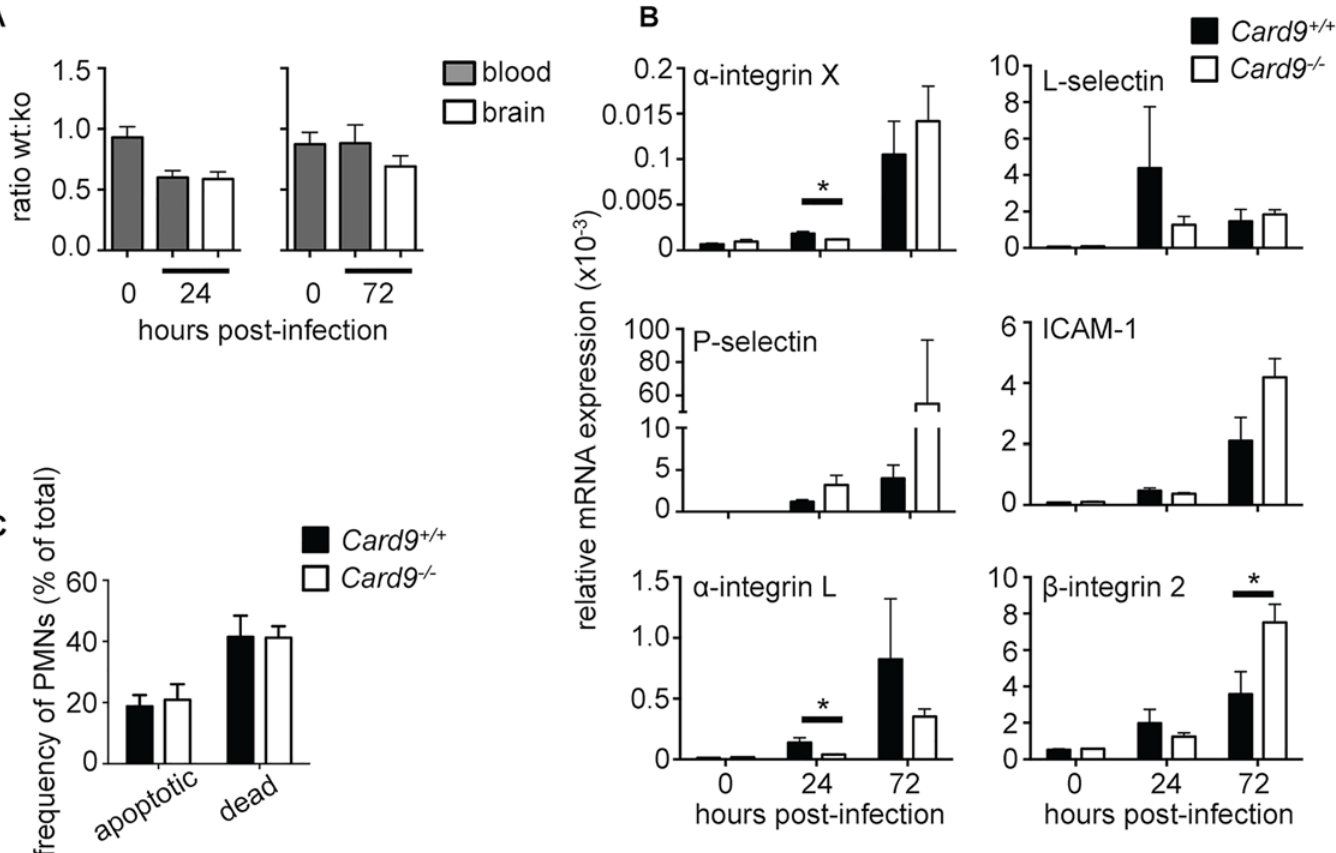
Fig 7. CARD9 deficiency does not affect cell-intrinsic neutrophil chemotaxis, survival or expression of adhesion molecules. (A ) The ratio of CD45.1 + WT neutrophils to CD45.2 + Card9 -/- neutrophils in mixed bone marrow chimeras was determined by FACS in the blood prior to infection and in the blood and brain at 24 (left panel) and 72 hours (right panel) post-infection (n = 7 – 8 per time point). ( B ) Expression of various adhesion molecules in whole brain homogenates of uninfected and infected WT (filled bars, n = 6) and Card9 -/- (empty bars, n = 6) mice, as determined by qRT-PCR. Gene expression was calculated relative to Gapdh. Mice analyzed at 24 hours were infected with 1.3x10 5 CFU SC5314, and mice analyzed at 72 hours infected with 7x10 4 CFU. ( C ) Neutrophil survival in the brain of 24-hour infected (dose: 1.3x10 5 CFU) WT (filled bars, n = 6) and Card9 -/- (empty bars, n = 6) mice was determined by Annexin-V and 7-AAD staining and analysis by FACS. Apoptotic neutrophils were defined as Annexin-V + 7-AAD - , while dead neutrophils were defined as Annexin-V + 7-AAD + . All data is pooled from two independent experiments; data represent mean ± SEM. * P < 0.05 by two-way